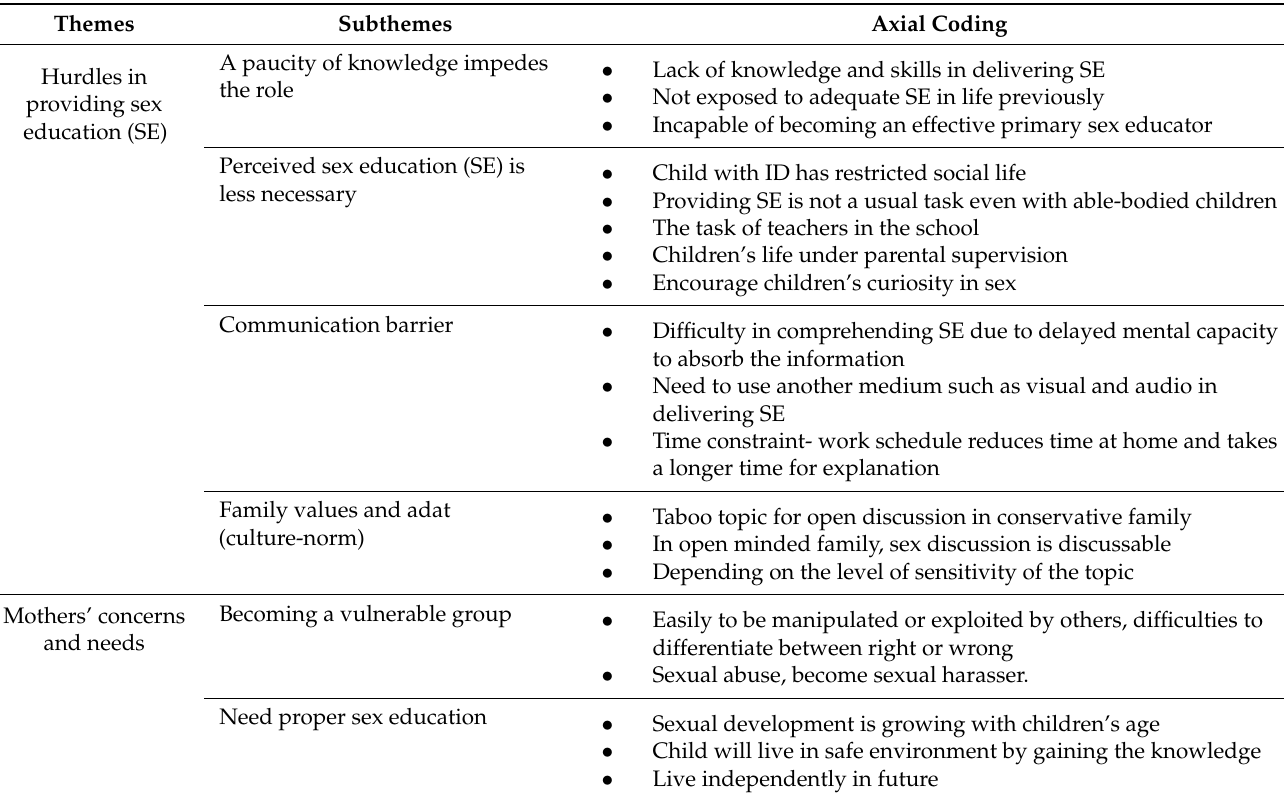
Table 2. Barriers and concerns in providing sex education among Malay mothers, (n =